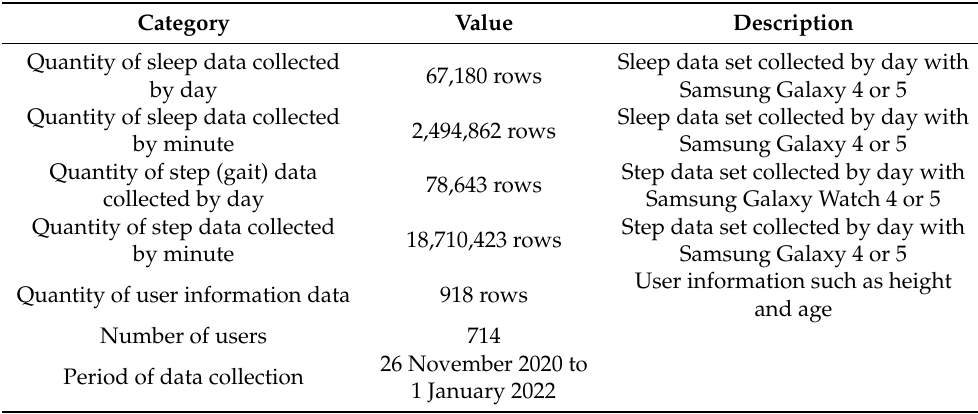
Table 1. Description of raw data collected from wearable devices (Samsung Galaxy